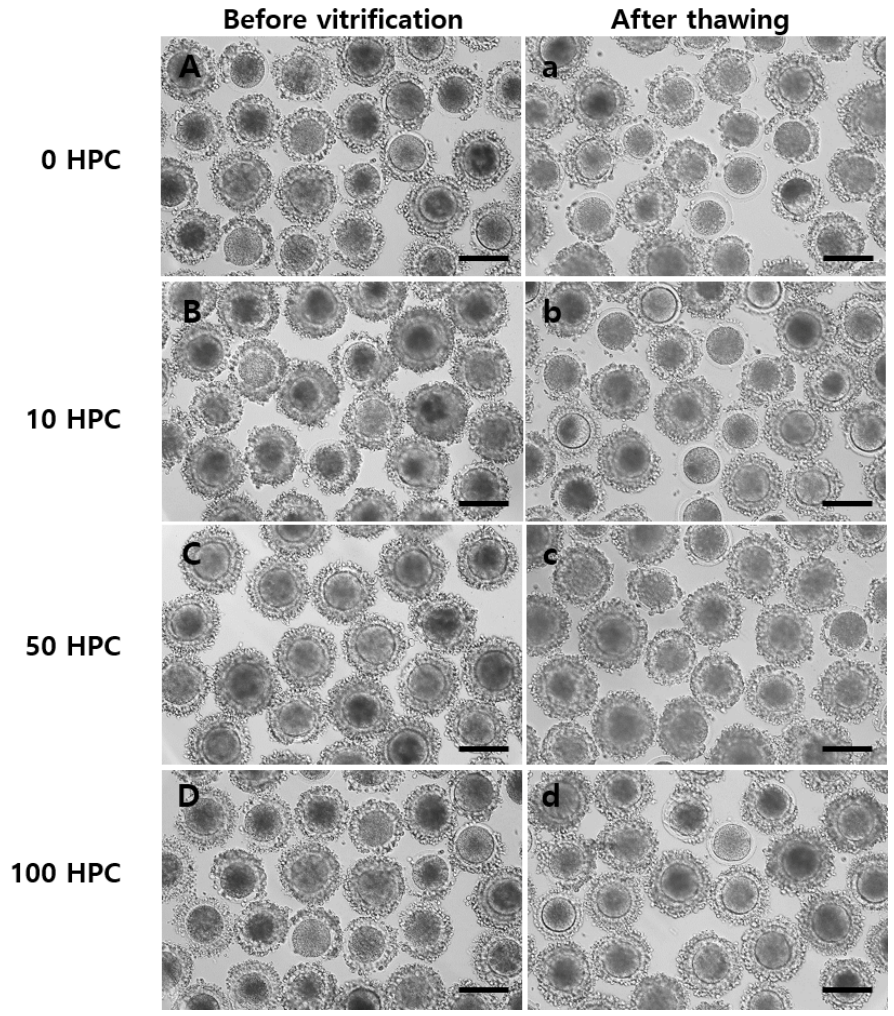
Figure 1. Morphologies of oocytes in the 0 ( A , a ), 10 ( B , b ), 50 ( C , c ), and 100 ( D , d ) HPC groups. ( A